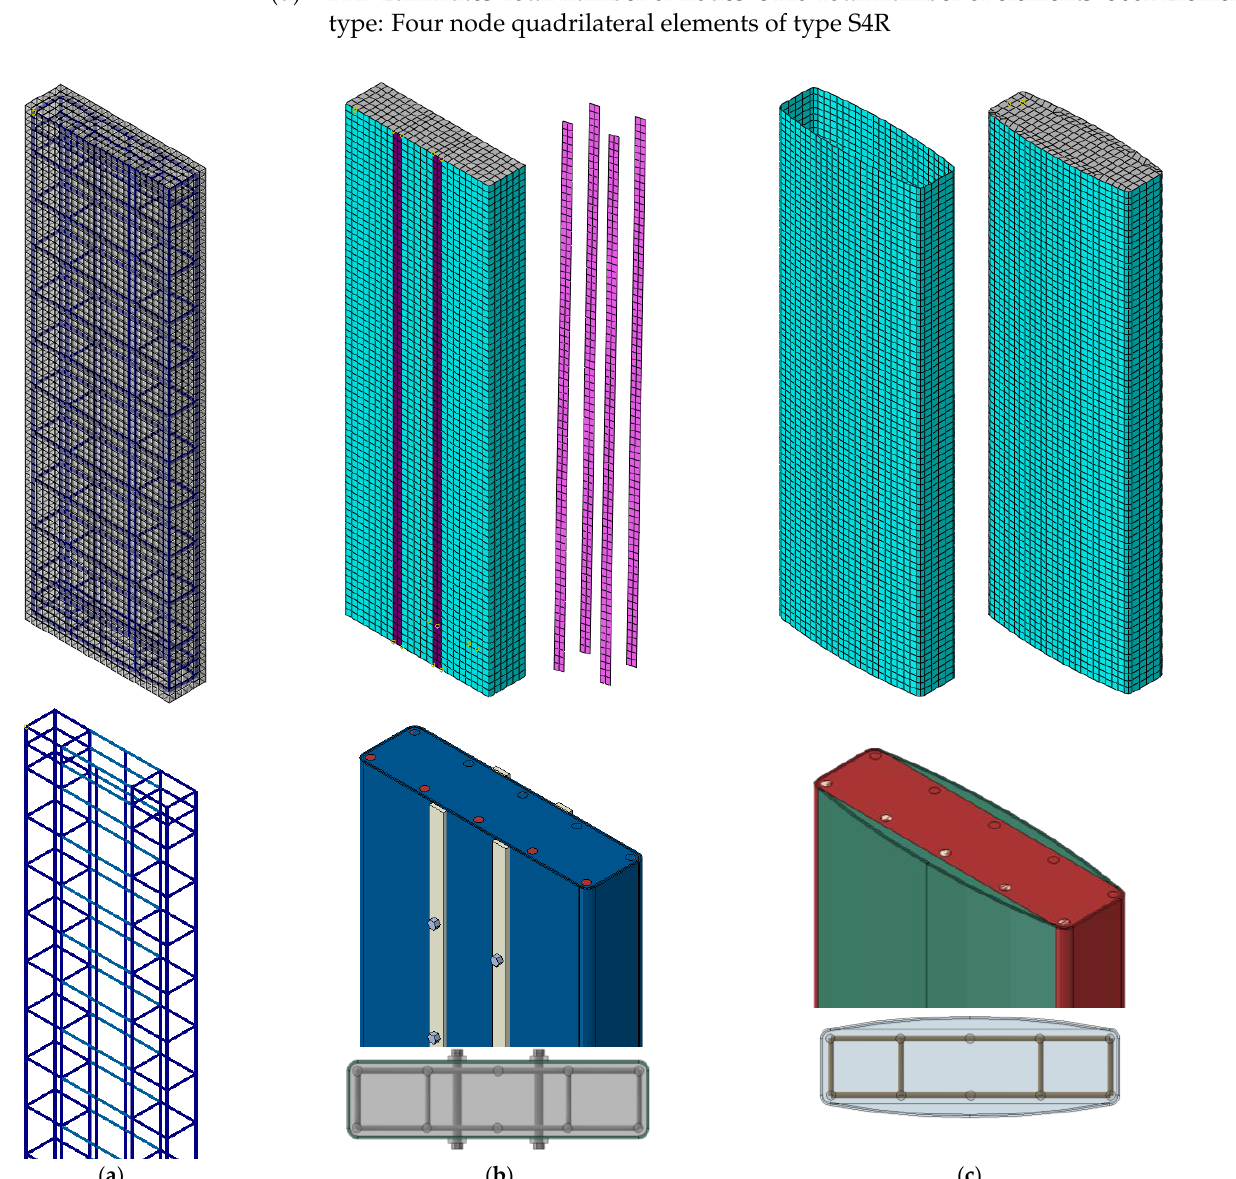
Figure 8. Finite element mesh for different columns: ( a ) control column; ( b ) column strengthened using Schemes 2 and 3; and ( c ) column strengthened using Schemes 1 and 4.